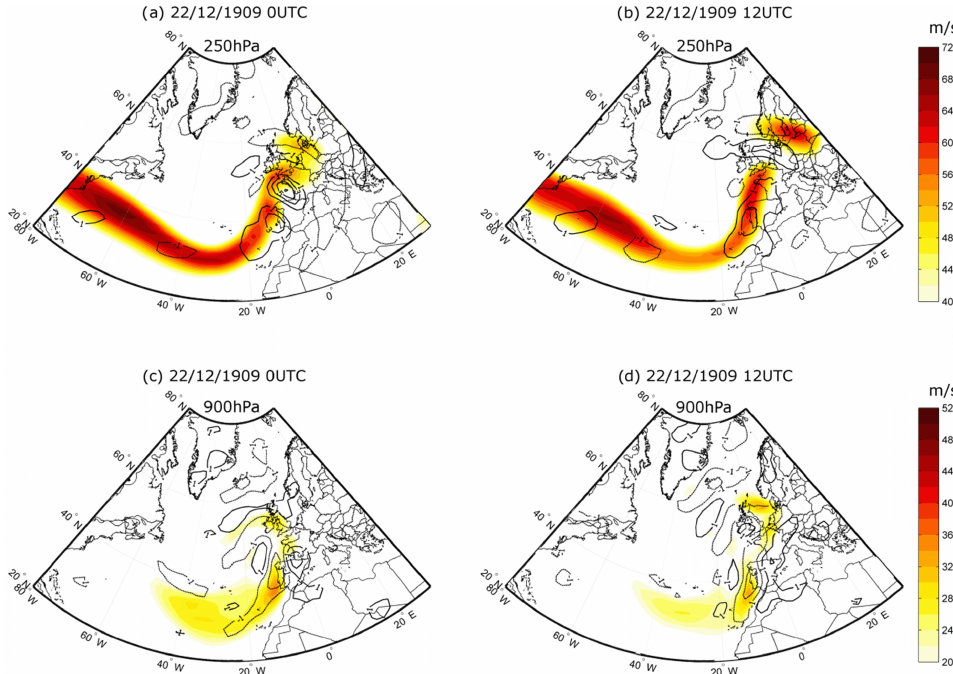
Figure 14. Divergence (contours; 10 − 5 s − 1 ) at 22 December 1909 at 00:00 and 12:00UTC for (a, b) the 250Pa level, and (c, d) at the 900Pa level. Along with the divergence field, the respective wind speed (shaded, ms − 1 ) is also shown.